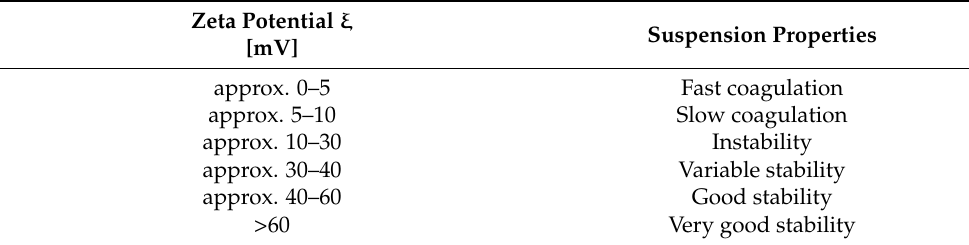
Table 2. Stability of suspension depending on the zeta potential, ξ